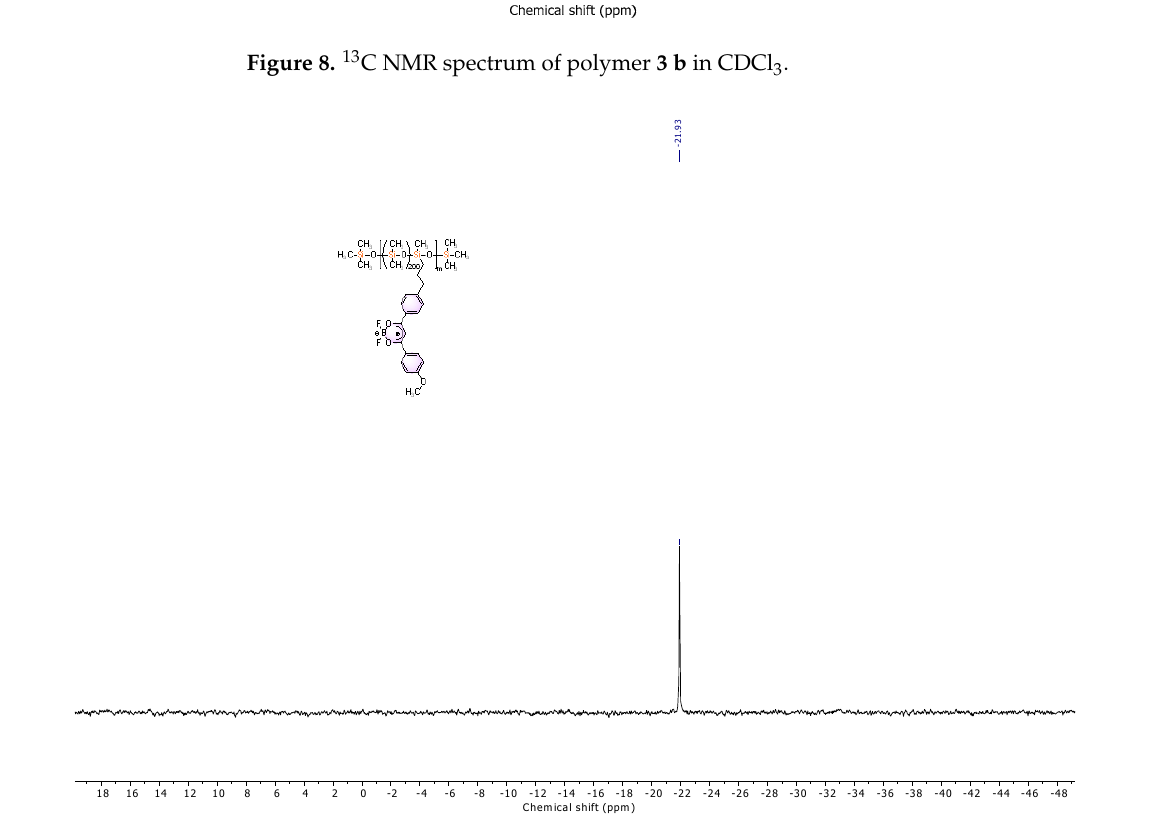
Figure 9. 29 Si NMR spectrum of polymer 3 b in CDCl 3 .